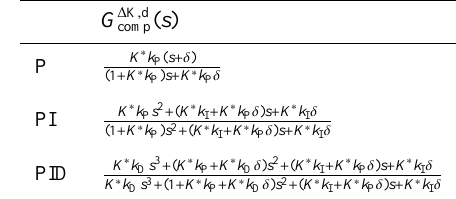
Table 8. Closed-loop transfer function G ∆ K , d comp considering a time- dependent sensitivity ˜ K instead of an ideal static sensitivity K by application of the drift model from Eq. (7) to the static sensor part (grey box in Fig. 13).